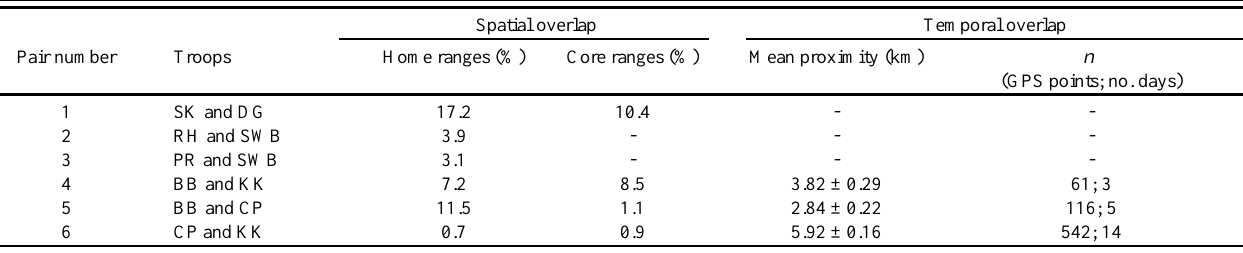
Table 4 . Details of the spatial overlap of troop home ranges and the mean (± SEM) temporal proximity of neighboring troops over a period of 17 days. Pair numbers correspond to the encircled numbers presented in Fig. 3. Troops are listed according to their geographical position from north to south.